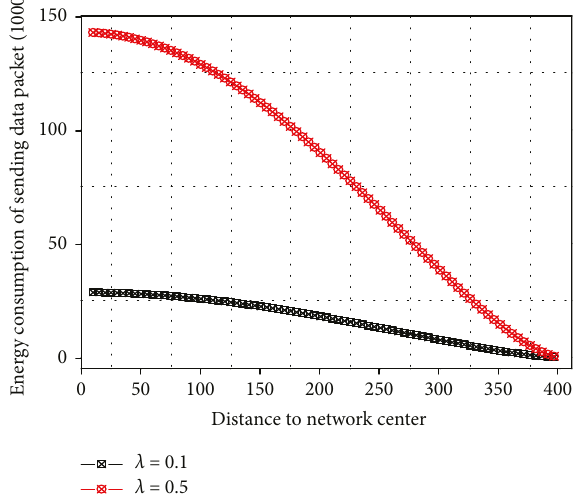
Figure 14: The amount of receiving data packet of nodes in di ff erent areas.